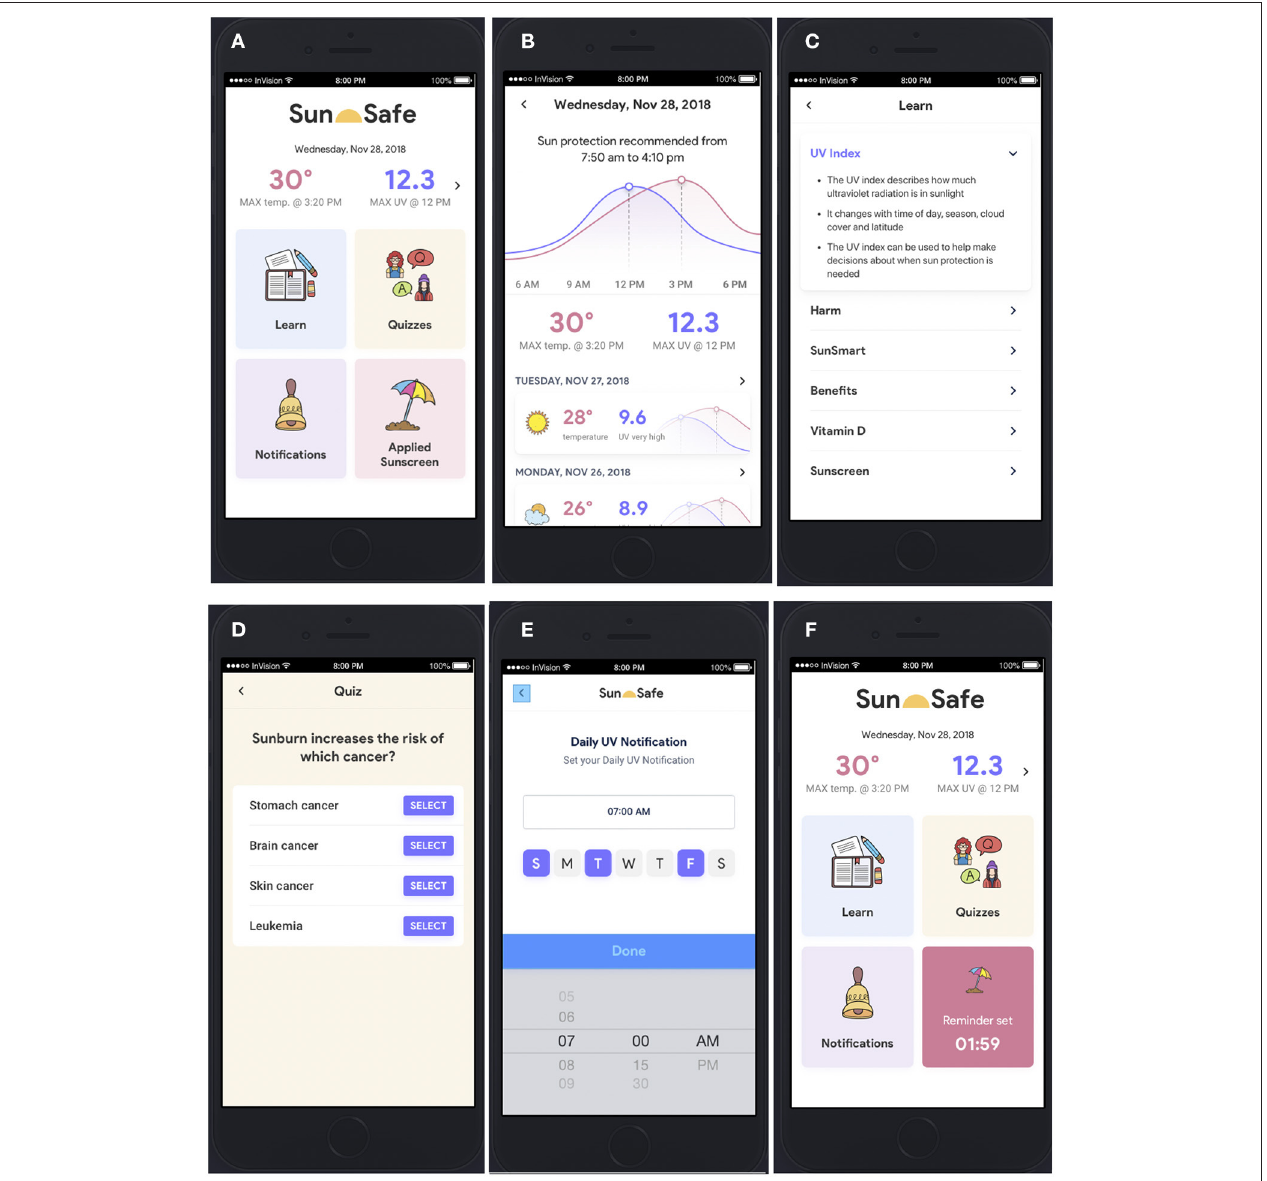
FIGURE 4 | Wireframe of the Sun Safe app. Features of the wireframe included: (A) home page with that day’s maximal UV Index and temperature data; (B) more detailed predictive data on the UV Index and temperature and times when to use sun protection (accessed via arrow on right-hand side of UV Index data on the